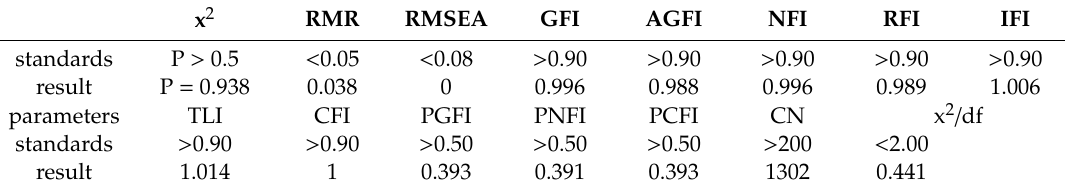
Table A2. Overall adaptation degree of the final influencing model.